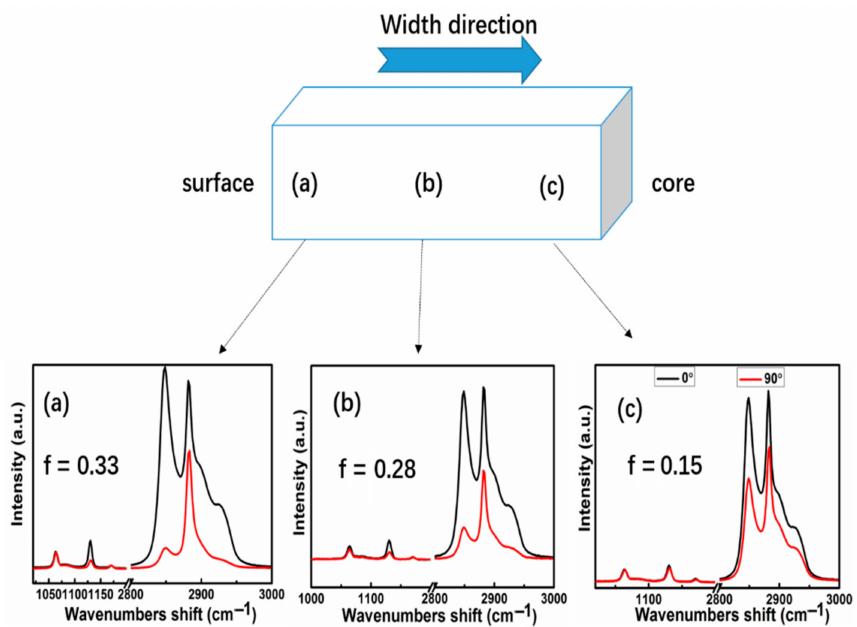
Figure 3. Polarized raman spectra of the UHMWPE samples along the transverse direction with 0 s residence time ( a – c